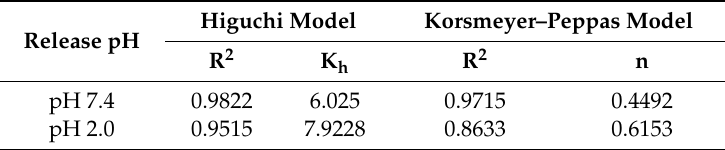
Table 4. Fitting experimental release data from the Ps release of 3D-printed sca ff olds to Higuchi and Korsmeyer–Peppas kinetic equations for neutral and acidic conditions (pH 7.4 and